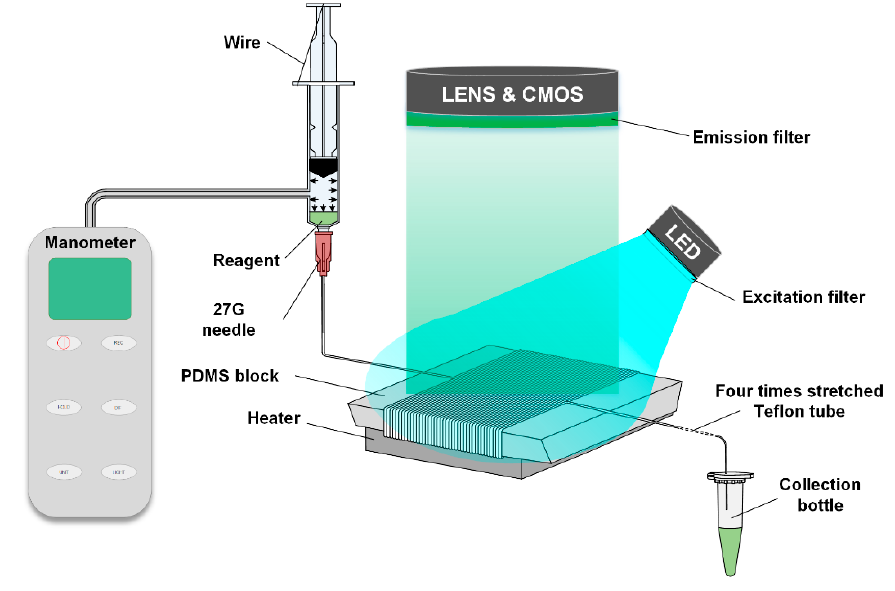
Figure 1. Principle of the end-opened system.